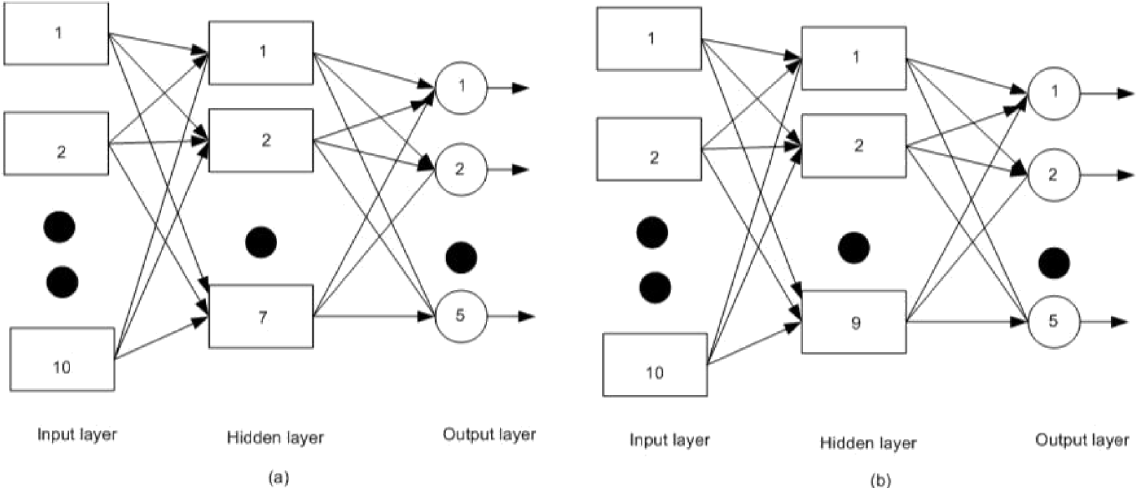
Figure 3. The pictorial representation of the (a) BPMLP and (b) RBF network models for classification of five different floral origins of